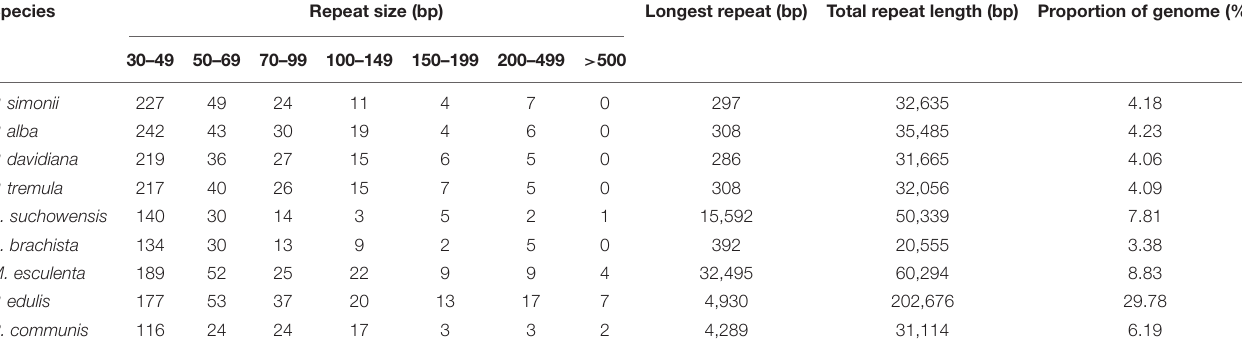
TABLE 3 | Comparison of dispersed repeats in nine Malpighiales plant mitogenomes.